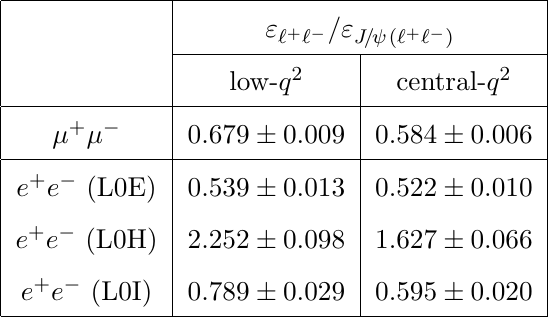
Table 3 . E(cid:14)ciency ratios between the nonresonant and resonant modes, " muon and electron (in the three trigger categories) channels. The uncertainties are statistical only.